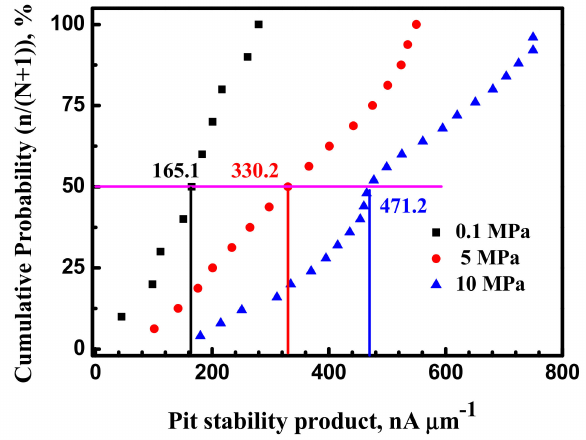
Figure 9. Cumulative distribution of metastable pits stability for the X70 steel at various hydrostatic pressure and − 100 mV vs. Ag/AgCl electrode.